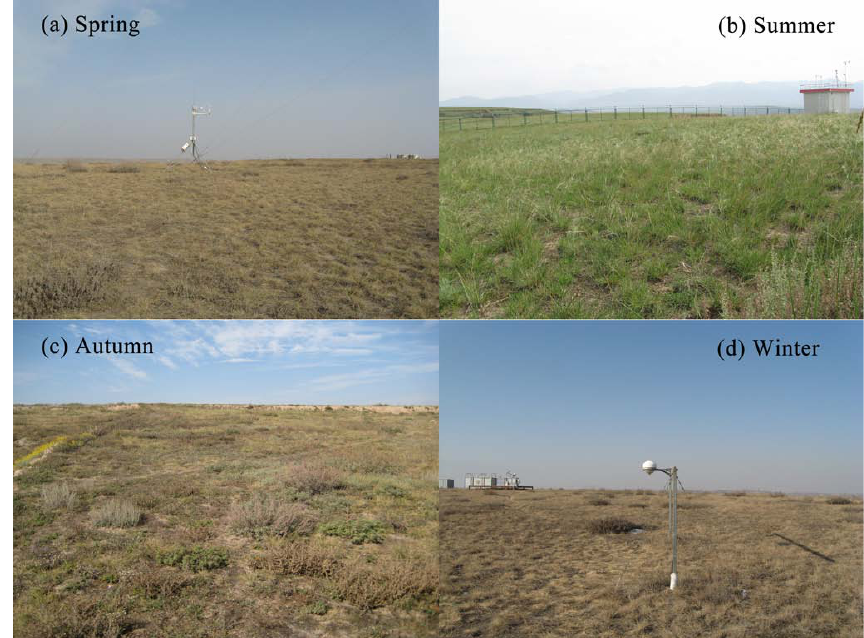
Fig. 1. Seasonal vegetation views of the SACOL